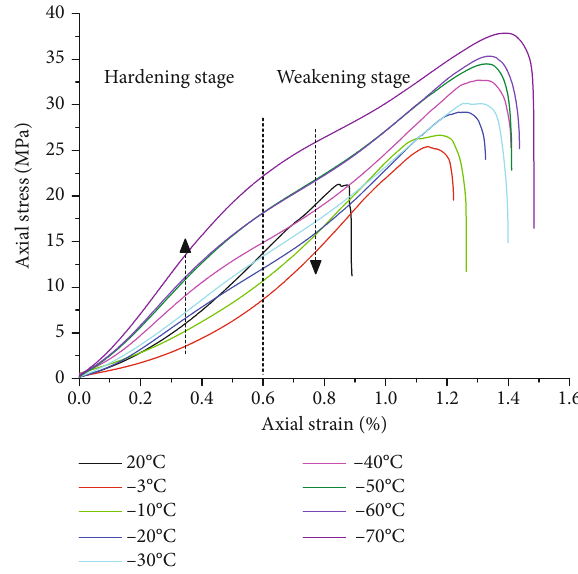
Figure 1: Uniaxial compressive stress-strain curves at various